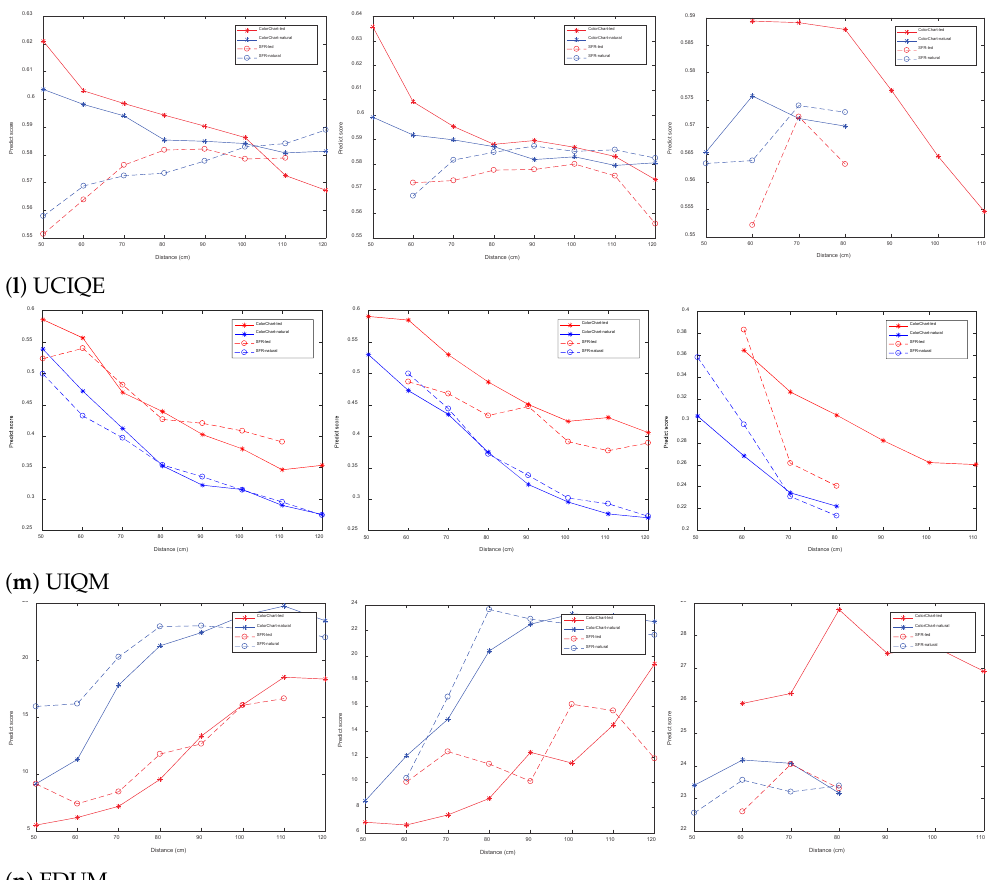
Figure 2. Predict score curves of each quality evaluation method on Tankimage-I. For the SFR board image, under the water transparency of 325 cm and artificial light source, as shown in Figure 3, when the imaging distance is small there is a bright reflection area in the image, which makes the local clarity of the image change, and with the increase of the imaging distance, the presence of suspended matter in the water makes the noise in the image, and the backward scattering becomes the main attenuation component, the evaluation result of UCIQE is in good agreement with the change of blurring degree of the SFR board. When the lighting condition is natural light, as shown in Figure 4, foggy blur and low contrast distortion caused by scattering are mainly present in the image. At this time, the scores of BRISQUE, HOSA and UCIQE are in good agreement with the change of blurring degree of SFR board. And the distortion when the water transparency is 182 cm is similar to the distortion when the water transparency is 325 cm. When the imaging distance is larger, the noise in the image under artificial light source is more serious, and the evaluation results of BRISQUE, HOSA and UIQM have better consistency in the change of blurring degree of SFR plate. And the consistency of the blurring degree change of SFR plate is better for the evaluation results of BRISQUE, SNPNIQE and UCIQE under natural light. (d is the imaging distance) For ColorChecker card images, the evaluation results of MsKLT and ILNIQE were in good agreement with the change of color distortion degree under the water transparency of 325 cm and artificial light source; the evaluation results of UCIQE were in good agreement with the change of color distortion degree under natural light. While the transparency of water body is 82 cm, the evaluation results of ILNIQE, UCIQE and UIQM under artificial light source are in better agreement with the change of color distortion